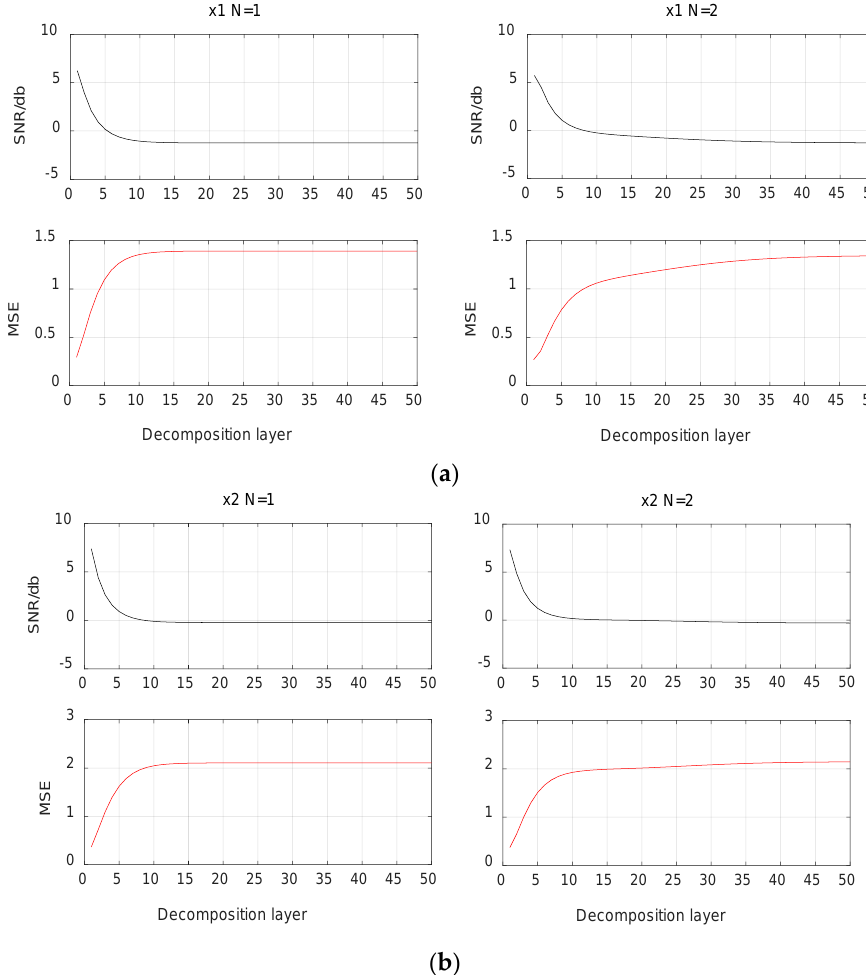
Figure 4. The SNR and MSE in the three-division method. ( a ) x1, ( b ) x2.